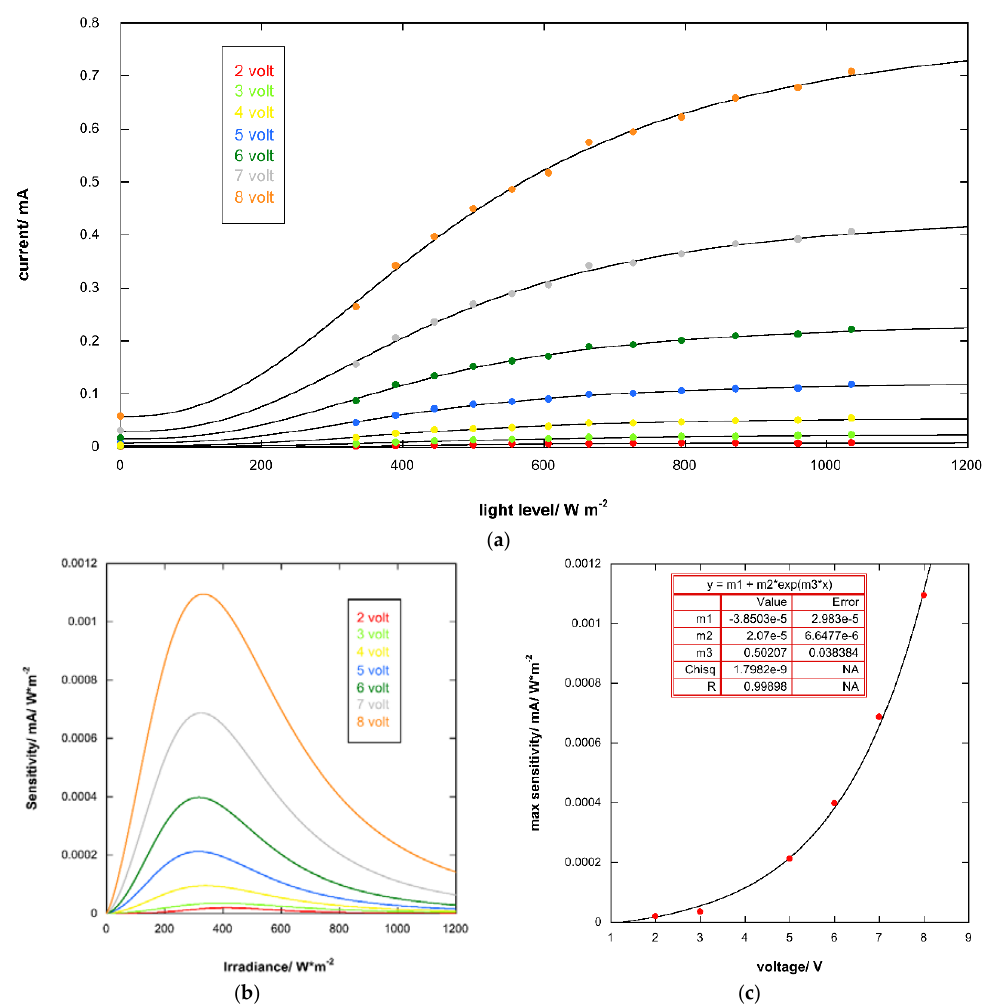
Figure 7. ( a ) Fit of current of photoresponsive device ( i ) vs. irradiance ( φ ) with a sigmoidal function; ( b ) Trend of sensitivity vs. irradiance; ( c ) Max sensitivity vs.